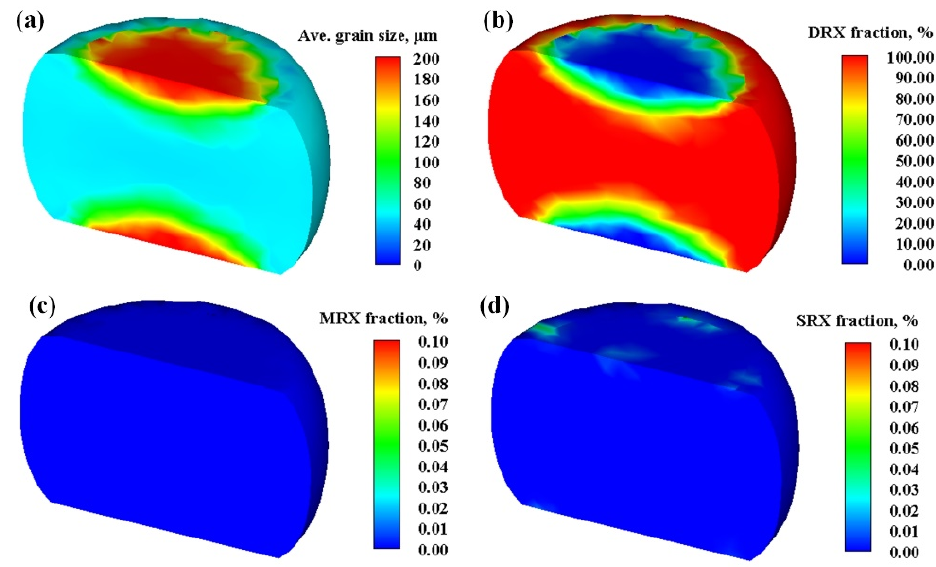
Figure 11. ( a ) Average grain size; ( b ) dynamic recrystallisation (DRX); ( c ) meta-recrystallisation (MRX); ( b , d ) static recrystallisation (SRX) fractions in the specimen after upsetting.